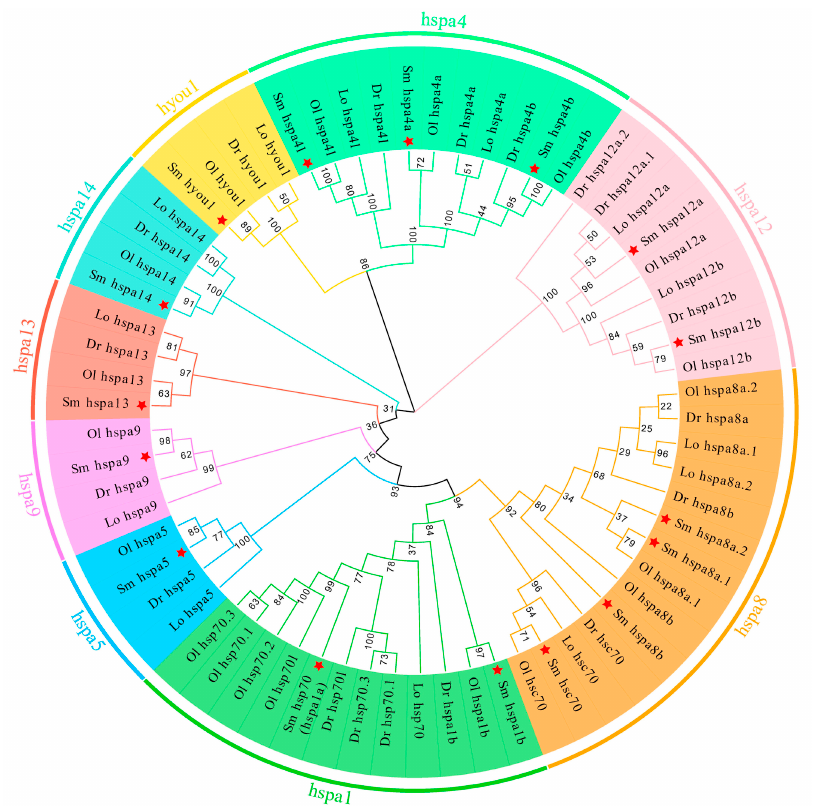
Figure 1. Phylogenetic analysis of HSP70 genes in four representative teleost species. A total of 66 HSP70 protein sequences from 4 teleost species were used to create the NJ tree using MEGA 11.0 with JTT model and 1000 bootstrap replications. Nine different groups were labeled as hspa1, 4, 5, 8, 9, 12, 13, 14, and hyou1 and distinguished by diverse colors. HSP70 genes of S. maximus were marked with a red asterisk. The abbreviations: Sm, S. maximus ; Dr, Danio rerio ; Ol, Oryzias latipes ; Lo, Lepisosteus oculatus .